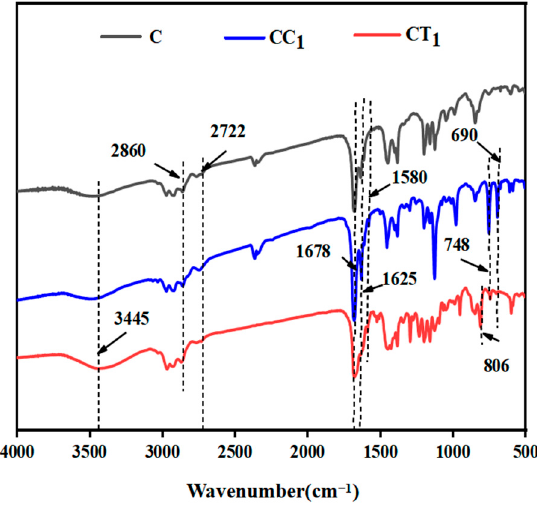
Figure 2. Infrared spectra of citral and citral compound solutions (C, citral solution; CC 1 , a com- pound formulated with citral and cinnamaldehyde; CT 1 , a compound formulated with citral and